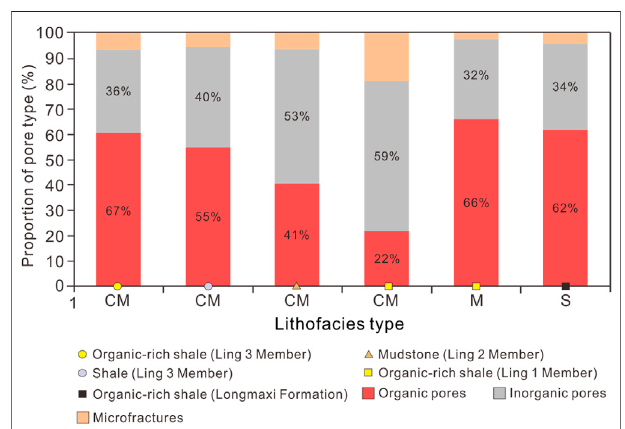
FIGURE6| High-resolutionSEMimageprocessingtechnologyshowing reservoir space proportion in Upper Permian Linghao Formation shale/